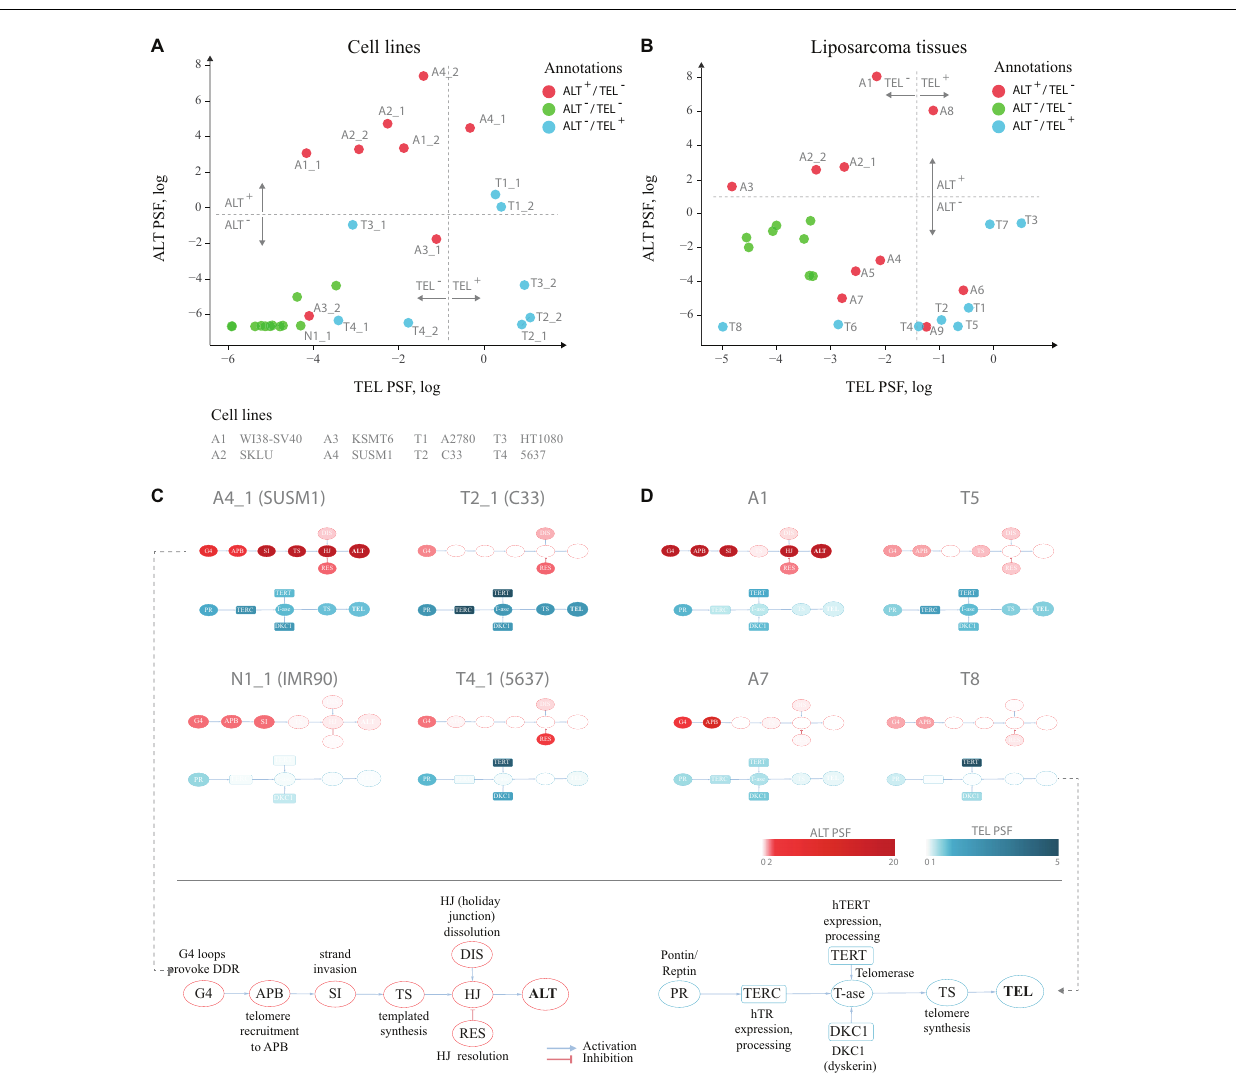
FIGURE 2 | TEL and ALT pathway activity plots for cell lines and liposarcoma tissues. (A) Cell lines and hMSCs plotted according to the TEL PSF ( x -axis) and ALT PSF ( y -axis) values. Color coding corresponds to experimental annotation of TMM states. Horizontal and vertical dash lines separate ALT + from ALT - and TEL + from TEL - experimentally annotated samples based on support vector machine classification on the ALT and the TEL PSF values. Technical replicates are distinguished with _1 and _2 suffices. (B) Similar representation for liposarcoma tissues and hMSCs. (C,D) Examples of pathway activation patterns of some cell lines (C) and liposarcoma tissues (D) . PSF values of process nodes are indicated on a light-to-dark color scale. Node abbreviations are explained in the bottom schemes. Pathway activity patterns for all the samples are shown in Supplementary Figures S2,S3